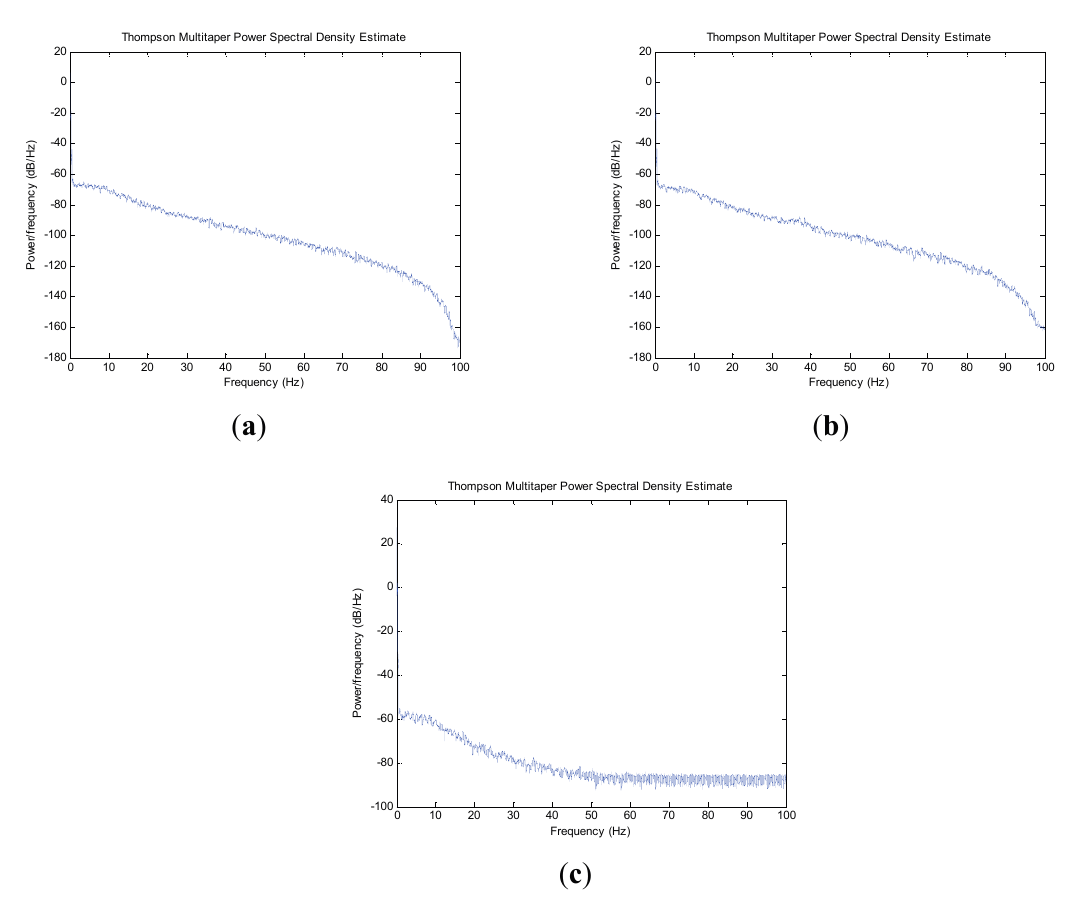
Figure 2. Spectral analysis of force observation in marble checking platform indoor: ( a ) in X direction; ( b ) in Y direction; ( c ) in Z direction.